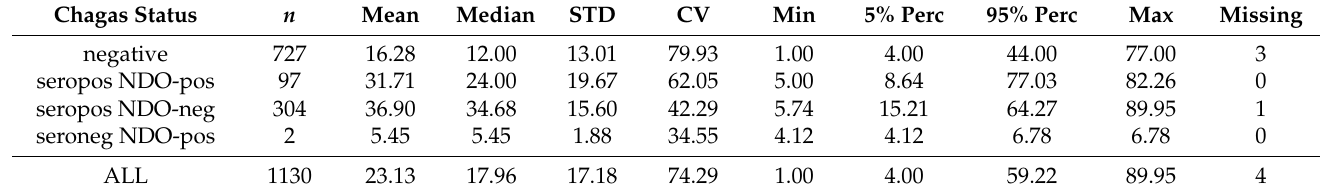
Table 3. Measures of age distribution by Chagas status in the entire study population ( n = 1134).